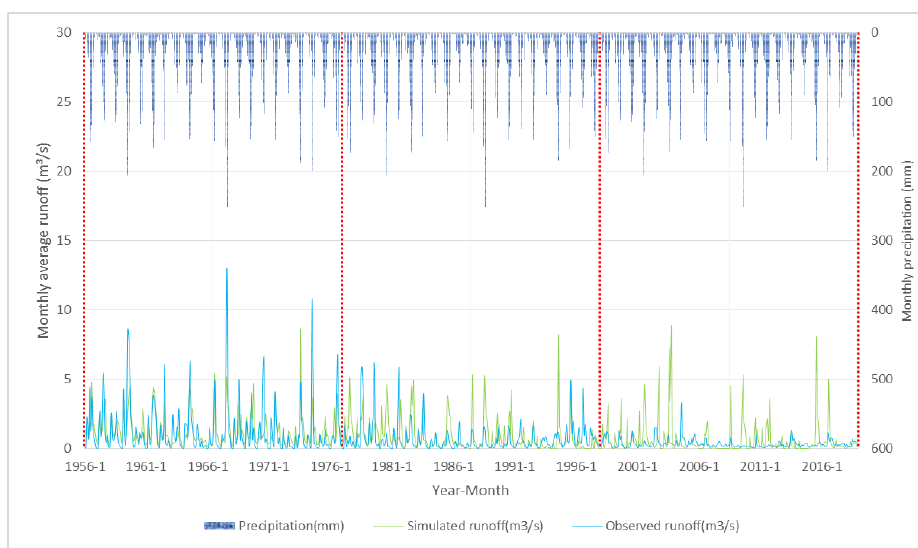
Figure 13. Simulated results of S2